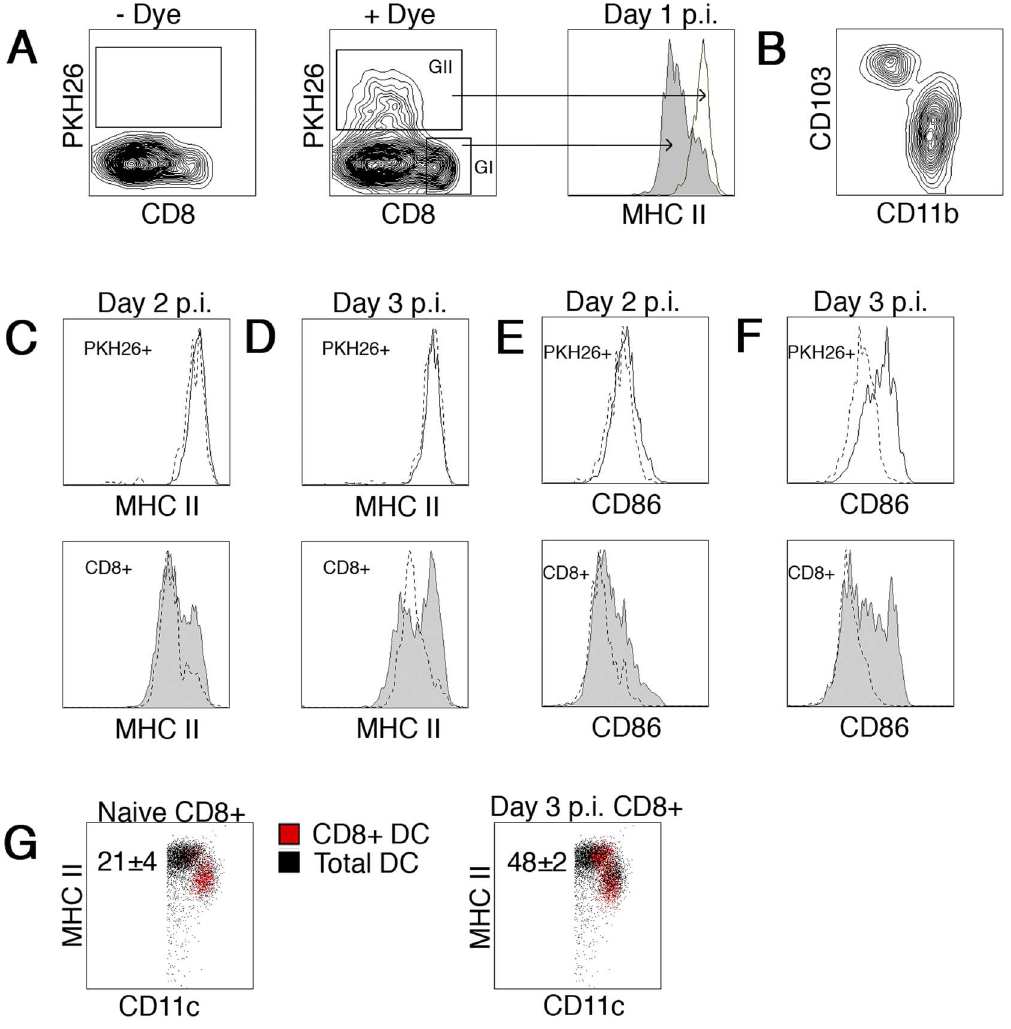
Figure 4. DC subset upregulation of MHC II during acute influenza infection. B6 mice were inoculated i.n. with PKH26 or carrier 16 hours before i.n. infection with influenza virus. One to three days post infection, individual lung draining mediastinal lymph nodes were harvested and DC isolated. Enriched DC were stained with anti-CD11c, anti-CD8, anti-CD103, anti-CD11b, and anti-MHC II and analyzed on a flow cytometer. (A) Representative FACS plots of – Dye (left) and + Dye (middle) treated animals are shown. In addition, a representative histogram overlay from day 1 post infection (right) shows expression of MHC II on the CD11c + CD8 + DC (Gate I-filled) and PKH26 + DC (Gate II-open) subsets. (B) Representative dot plot of pKH26 + cells expression of CD103 and CD11b. (C–D) Upper histograms are an overlay showing expression of MHC II on PKH26 + cells from naı¨ve (dotted line) or PR8 infected (open) mice day 2 (C) or day 3 (D) post infection. Lower histograms are identical with exception they represent CD8 + DC from naı¨ve (dotted line) or PR8 infected (filled) mice. (E–F) Similar to C–D, with the exception expression of CD86 is shown. (G) Dot plot shows CD8 + DC (red dots) from naı¨ve (left) or D3 PR8 infected (right) mice as compared to total CD11c + DC from naı¨ve mice. The numbers in each plot represent the frequency of CD8 + DC in the MHC II high population. Representative histograms from 1 of 5 mice from two independent experiments are shown.